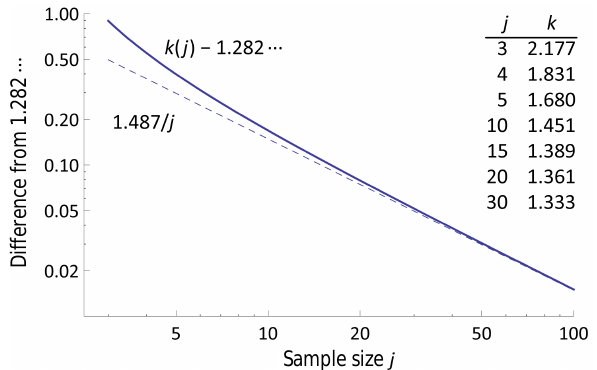
Figure 7. Sixty-station Mean Absolute P50 Error derived from es- timate based on 5-year sample segment separated final 20-year seg- ment by indicated interlude.